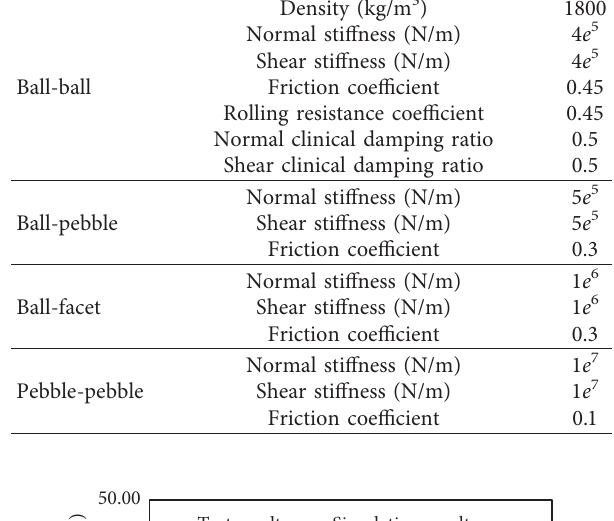
Table 1: Contact parameters of particle materials.